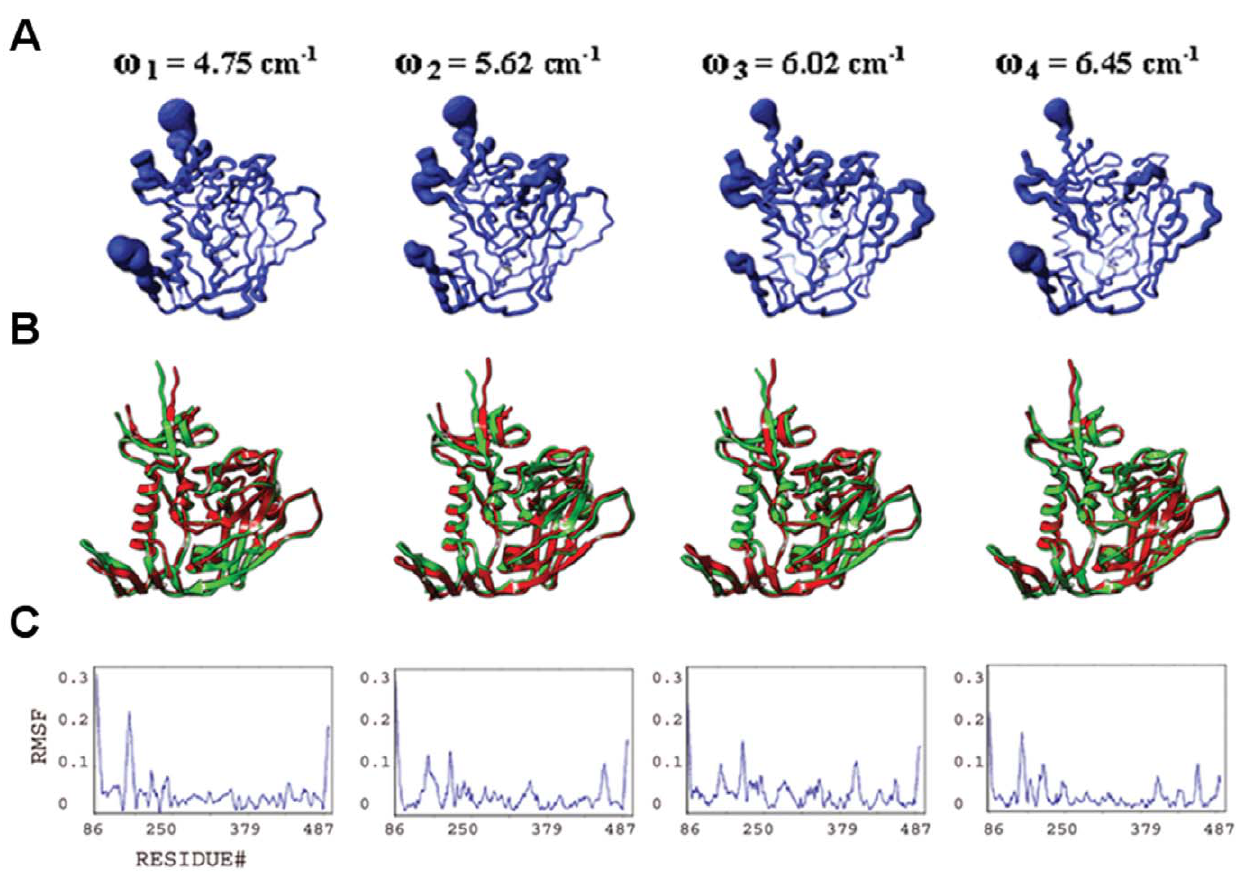
Figure 6. Conformational plasticity of gp120:CD4M33. Features from the four slowest modes analyzed and displayed as in Figure 3, but for gp120 in its complex with CD4 mimetic CD4M33. ( A ) Fluctuations mapped onto worm diagrams. ( B ) Superposition of conformers generated at extremes of the fluctuations. ( C ) Alpha-carbon RMSF plots.